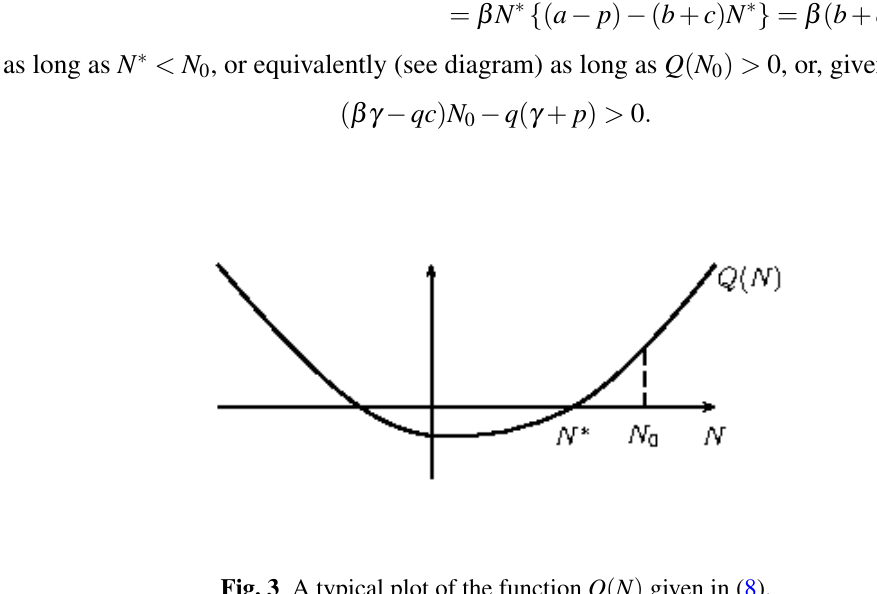
Fig. 3 A typical plot of the function Q ( N ) given in